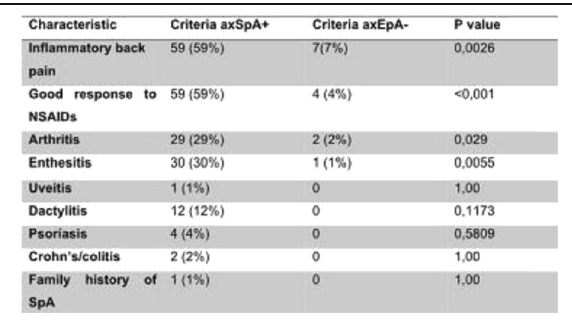
Table 1 (abstract P066). CLINICAL FEATURES AMONG PATIENTS IN THE